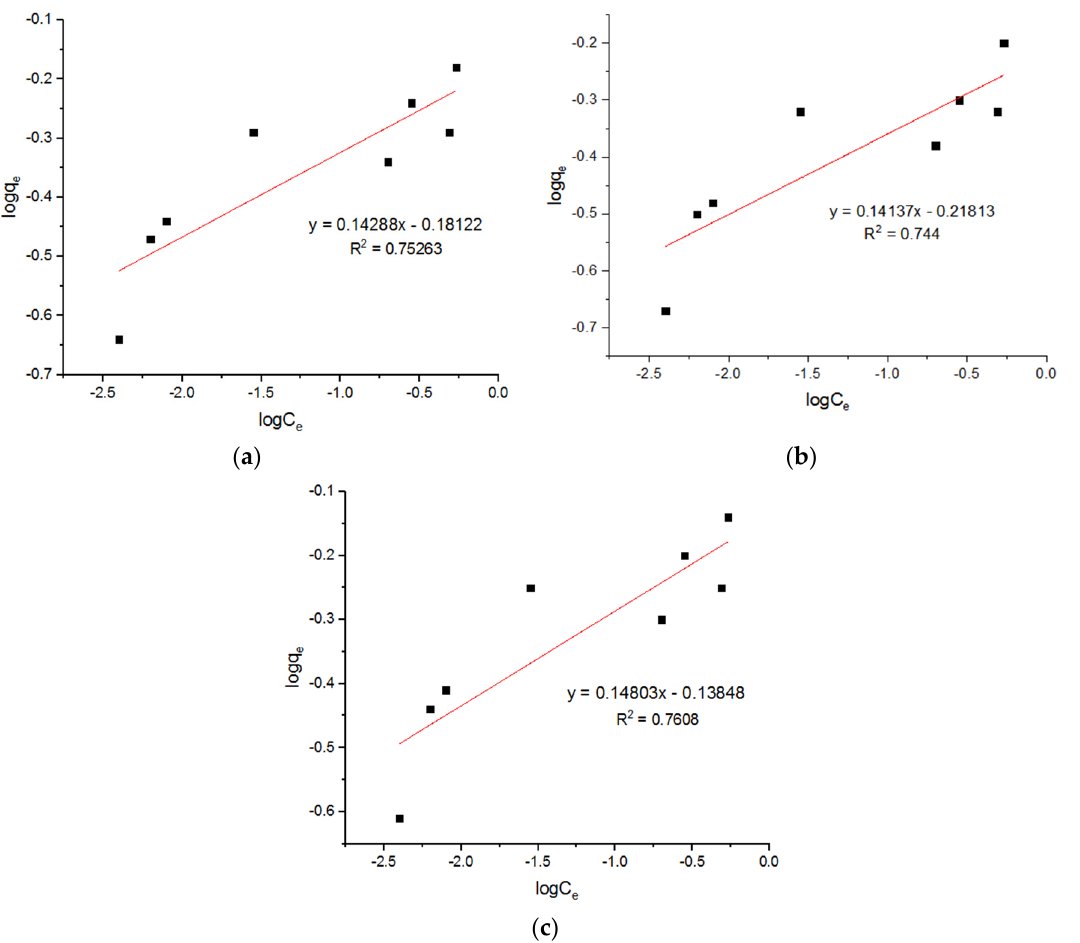
Figure 18. Freundlich plots for adsorption of Zn 2+ ions onto MgFe 2 O 4 -NH 2 nanoparticles pre-functionalization-calcined at ( a ) 500 °C, ( b ) 600 °C, and ( c ) 700 °C. Table 6. Isotherm parameters calculated from Langmuir model.